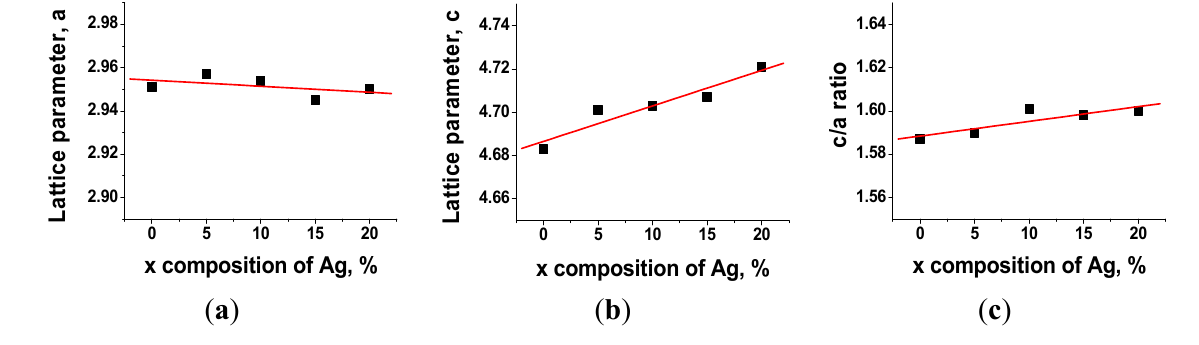
Figure 2. ( a , b ) Lattice parameters ( a and c ) of cp-Ti and as-cast Ti- x Ag alloys and ( c ) the variation in the ratio ( c / a ) of lattice